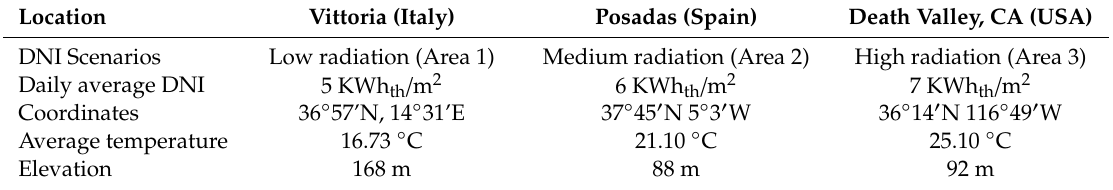
Table 1. Representative considered Direct Normal Irradiance (DNI) investment